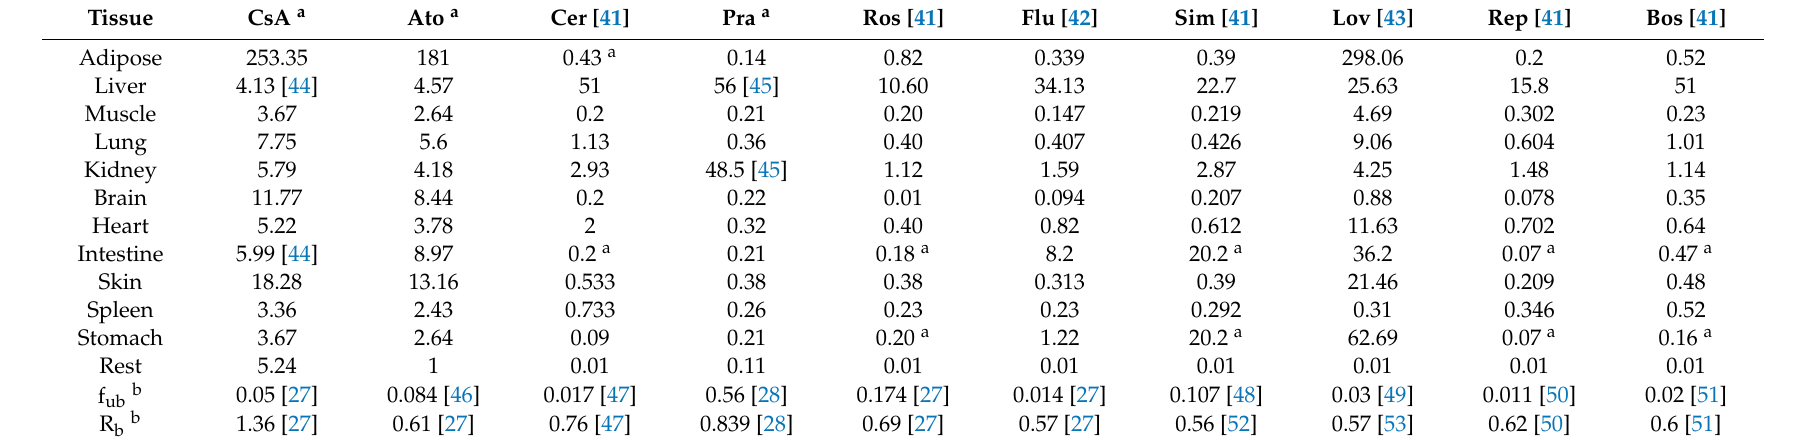
Table 2. Ratio of drug concentration in tissue to plasma for cyclosporin A (CsA), atorvastatin (Ato), cerivastatin (Cer), pravastatin (Pra), rosuvastatin (Ros), fluvastatin (Flu), simvastatin (Sim), bosentan (Bos), repaglinide (Rep) and lovastatin (Lov). Tissue CsA a Ato a Pra a Adipose 253.35